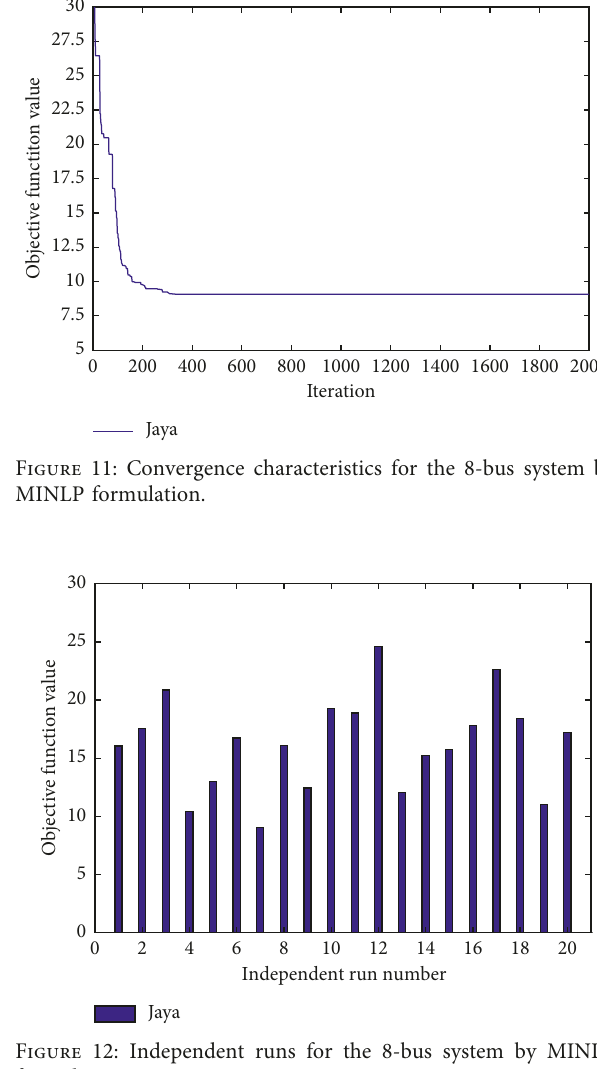
Figure 12: Independent runs for the 8-bus system by MINLP